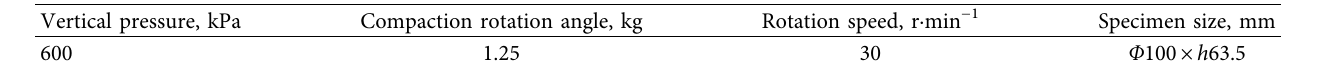
Table 5: Working parameters of the SGC method.